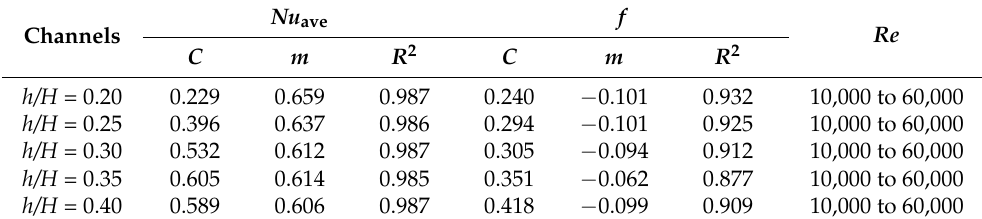
Table 4. Fitting parameter values of heat transfer and friction